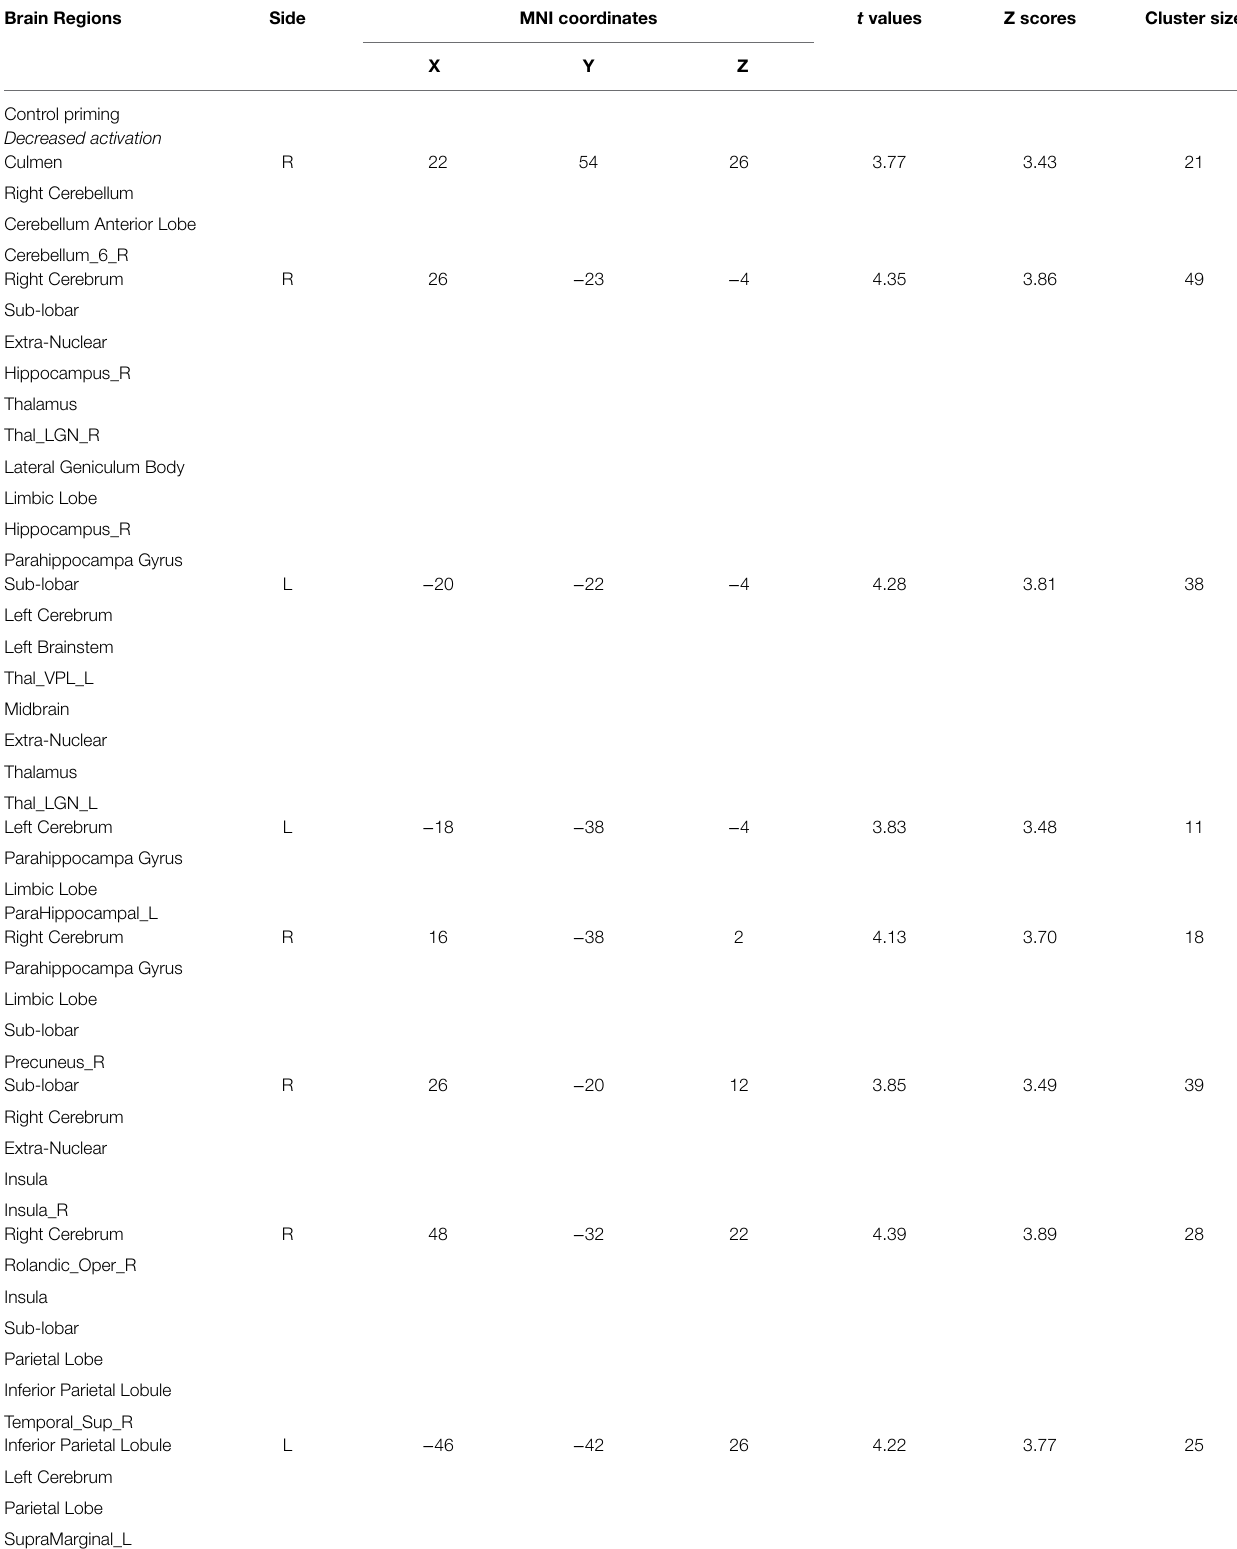
TABLE 4 | Correlations with attachment anxiety. Brain